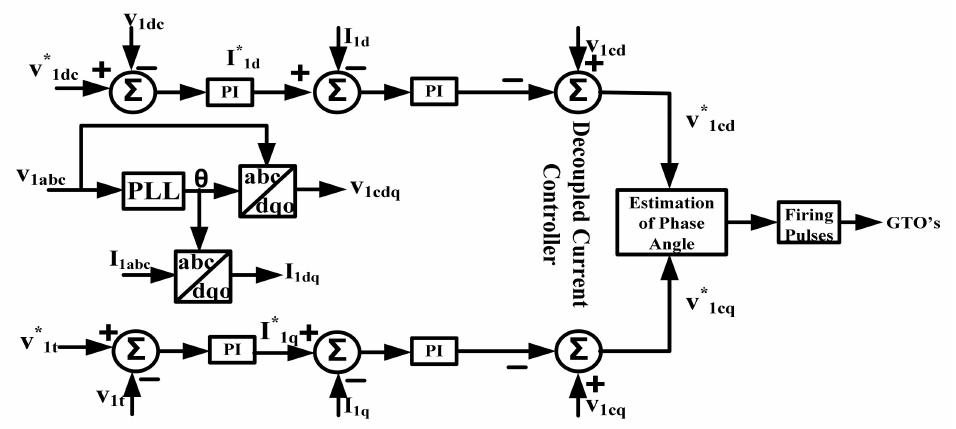
Figure 2. Control strategy for the proposed